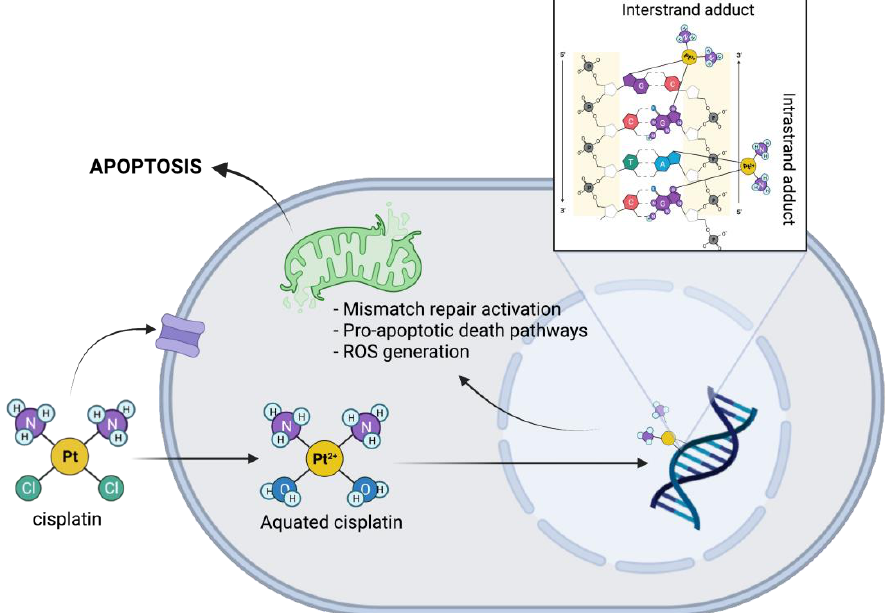
Figure 1. Mechanism of action of cisplatin in tumour cells. Cisplatin enters the cell either passively or through a transporter, where two water molecules replace the chloride groups. As an electrophile, cisplatin is attracted to the nitrogen on purine bases in the DNA, where it forms inter or intra-strand crosslinks, interrupting DNA repair and replication processes. Downstream this leads to oxidative stress and activation of apoptotic signalling pathways.